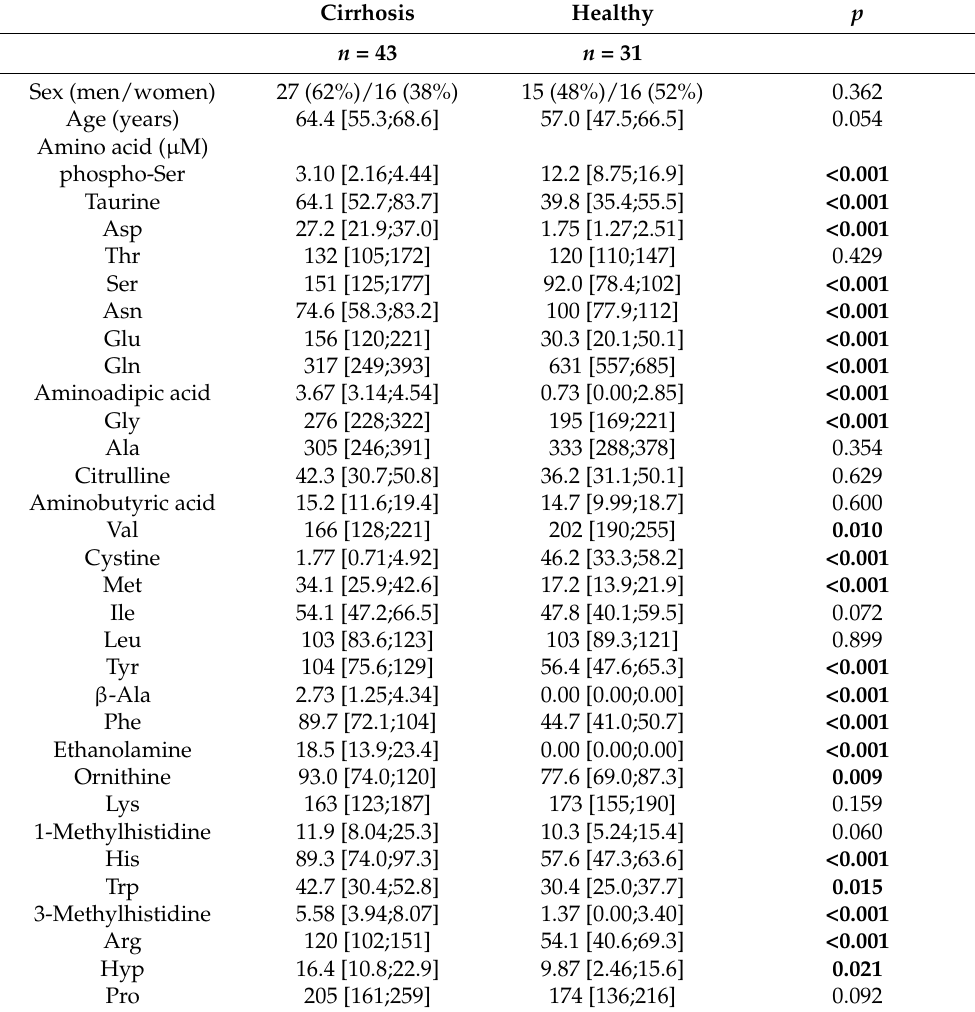
Table 1. Plasma amino acid concentration in patients with cirrhosis compared to healthy controls.